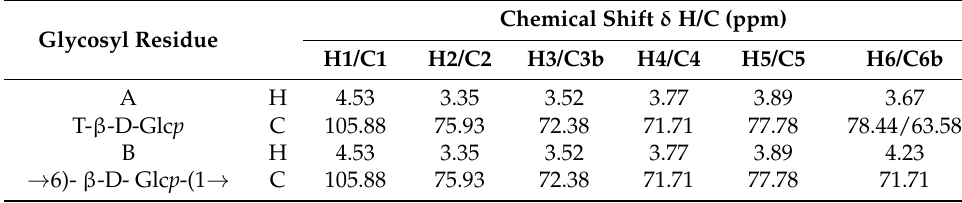
Table 6. 1 H and 13 C NMR chemical shifts of CHFVP-2 fraction recorded in D 2 O at 291 K.